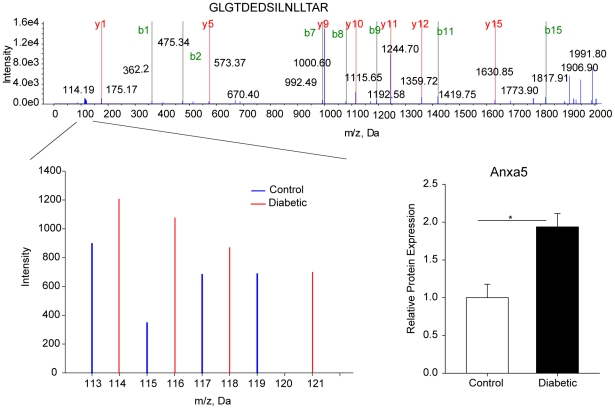
Examples of a differentially-expressed protein identified by iTRAQ.Retinal protein isolated from four diabetic and four age-matched control rats was labeled with isobaric tags prior to separation, identification, and quantitation by 8-plex iTRAQ using LC/MS/MS. An example MS/MS spectrum and the corresponding quantitation data (magnification of iTRAQ signal region) for a confidently identified (>95%) peptide component of Anxa5 are depicted. The signal intensities of all confidently identified peptides unique to Anxa5 were compiled to quantify Anxa5 expression. Anxa5 was significantly increased by approximately two-fold in three-month diabetic rats compared to controls. * p<0.05, two-tailed t-test, n = 4/group.